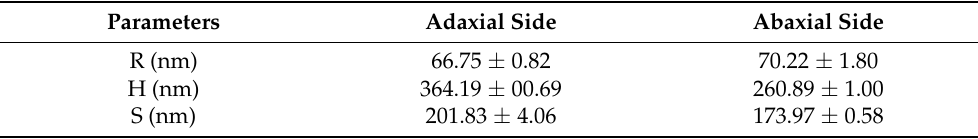
Table 1. Parameters of nanopillars on the banana leaf